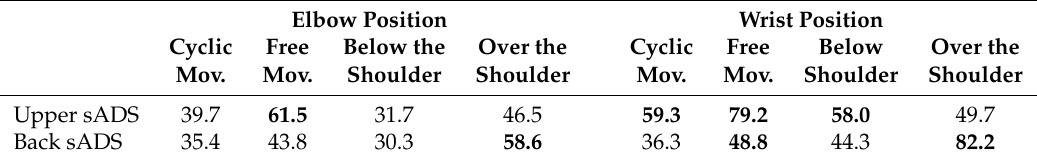
Table 6. Error for the estimated position by the shoulder sADS given in RMSE (mm). Elbow Position Wrist Position Cyclic Free Over the Cyclic Mov. Mov.